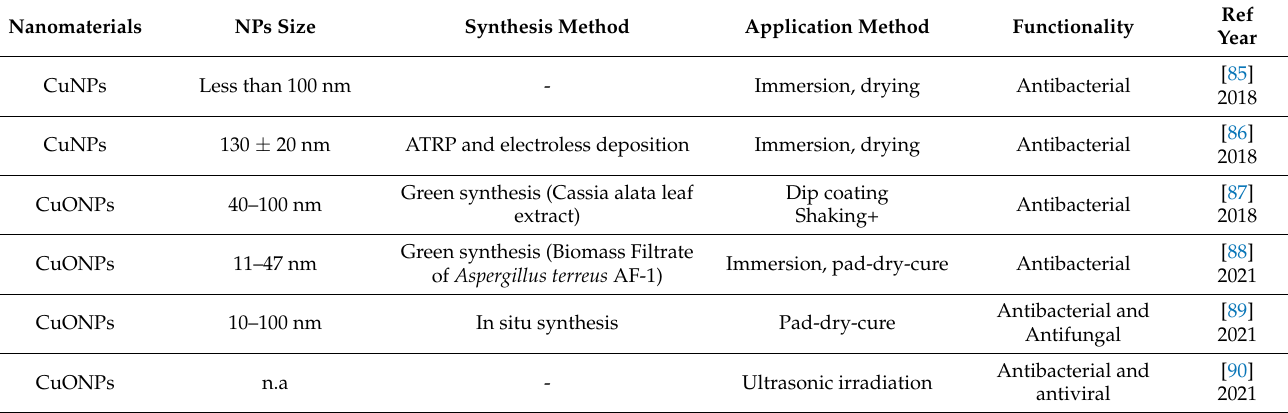
Table 5. Summary of the functionalization of cotton fabrics with